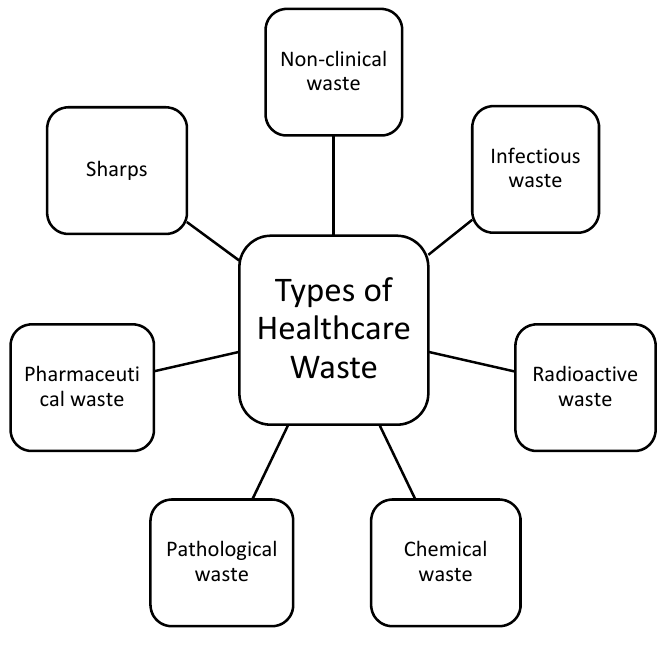
Figure 1. Types of HCW generated.